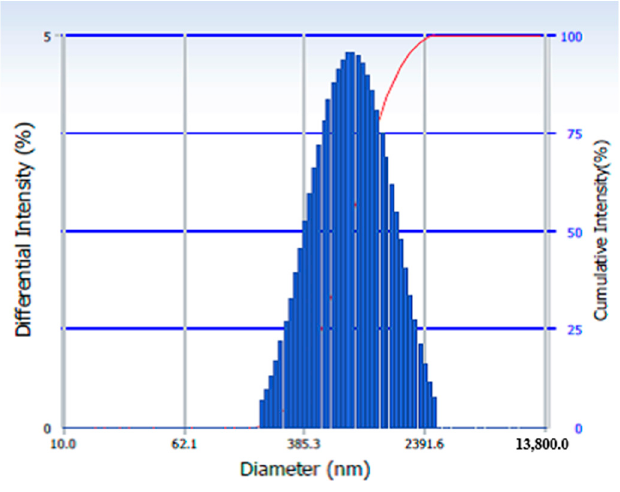
Figure 3. Hydrodynamic diameter distribution determined by DLS analysis.